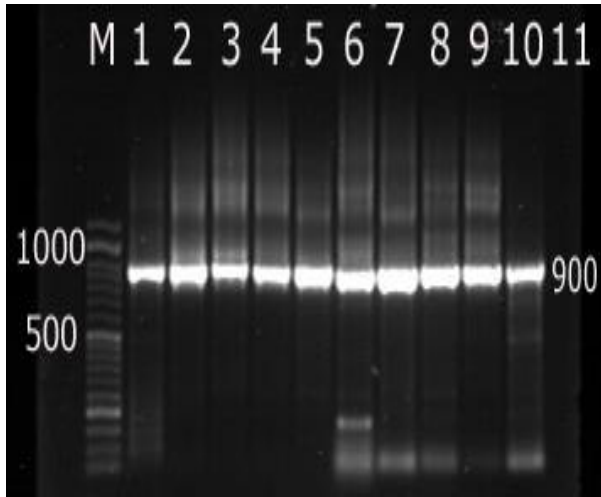
Figure 1. Polymerase chain reaction (PCR) products of amplified 16S rRNA of Listeria spp. Lane M = DNA ladder 50 bp; Lane 1 – 9 = positive strains with specific bands at 900 bp; Lane 10 = positive control ( L. monocytogenes ATCC 7644); Lane 11 = negative control ( Bifidobacterium breve ATCC 15700).